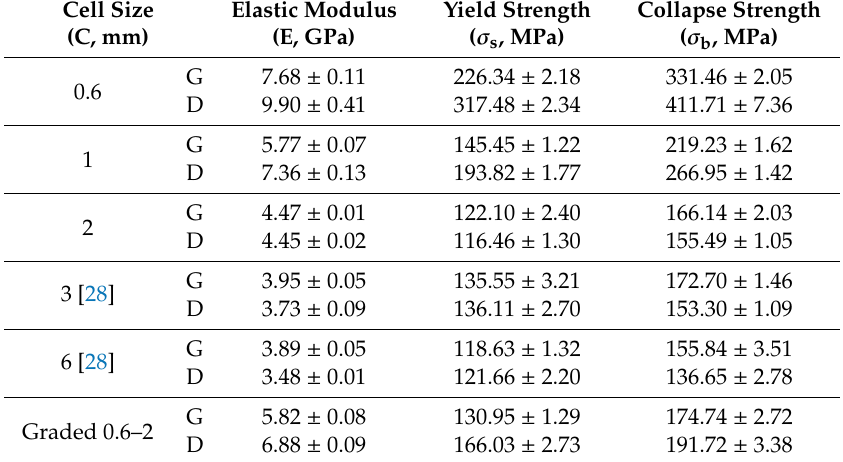
Table 2. Designed characteristics and results of static compressive tests of cellular gradients in three